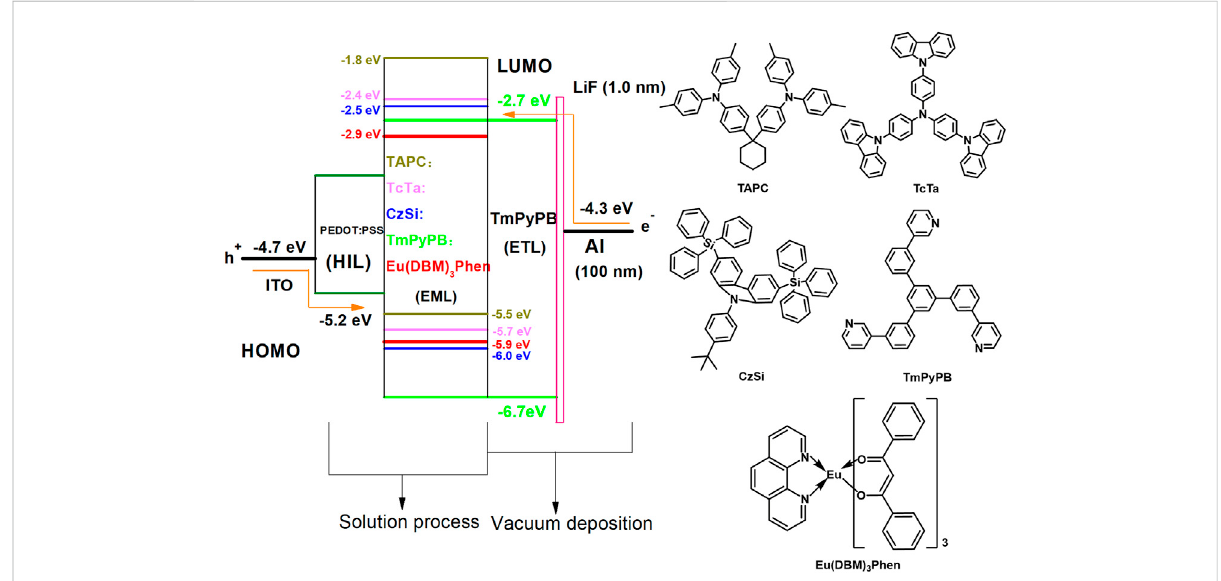
FIGURE 1 Proposed energy levels ’ diagram of the designed OLEDs and the molecular structures of TAPC, TcTa, CzSi, TmPyPB, and Eu (DBM) 3